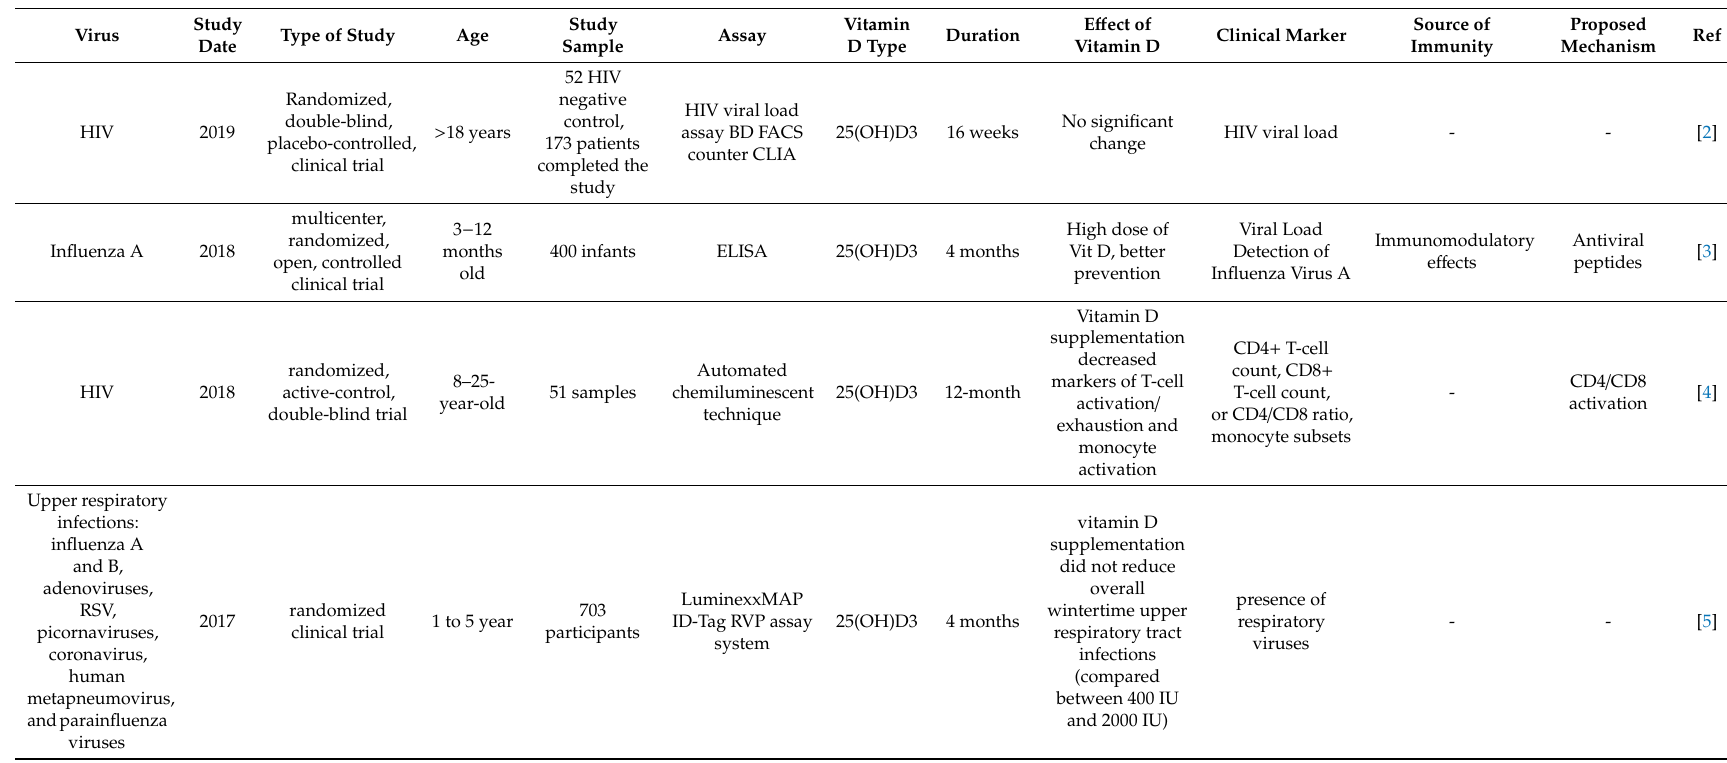
Table 1. Latest articles describe the immune modulatory e ff ect of Vitamin D on viral